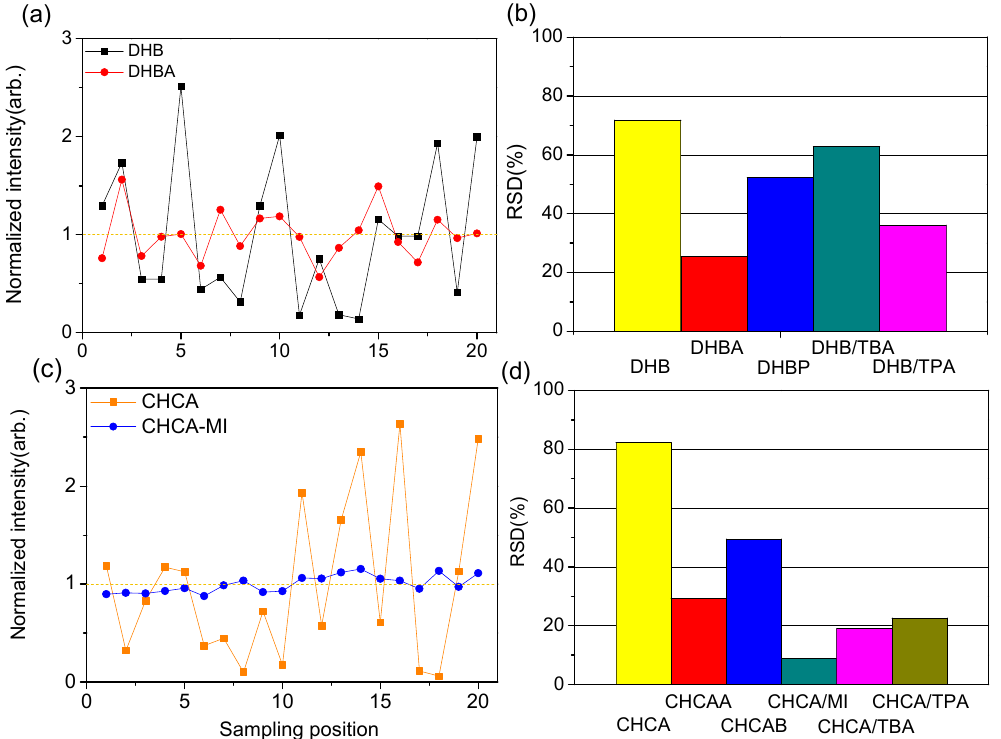
Figure 4. Plot of normalized [ATP-H] − signal distribution of ( a ) DHB (black square) and DHBA IL (red circle) and ( c ) CHCA (orange square) and CHCA / MI IL (blue circle). The averaged RSD value in 20 different positions of ( b ) DHB ILs and ( d ) CHCA ILs. Each sampling spot was irradiated by 1000 laser shots.